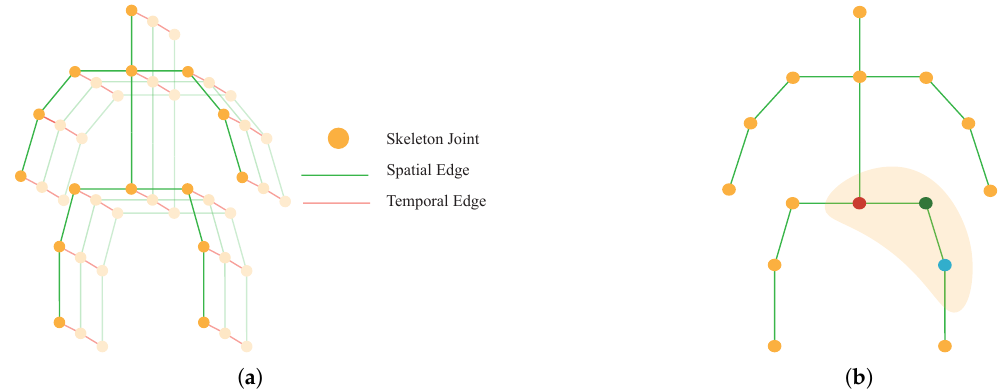
Figure 3. ( a ) Spatio-temporal graph of skeleton joints; ( b ) Mapping of different joints in the graph depending on their